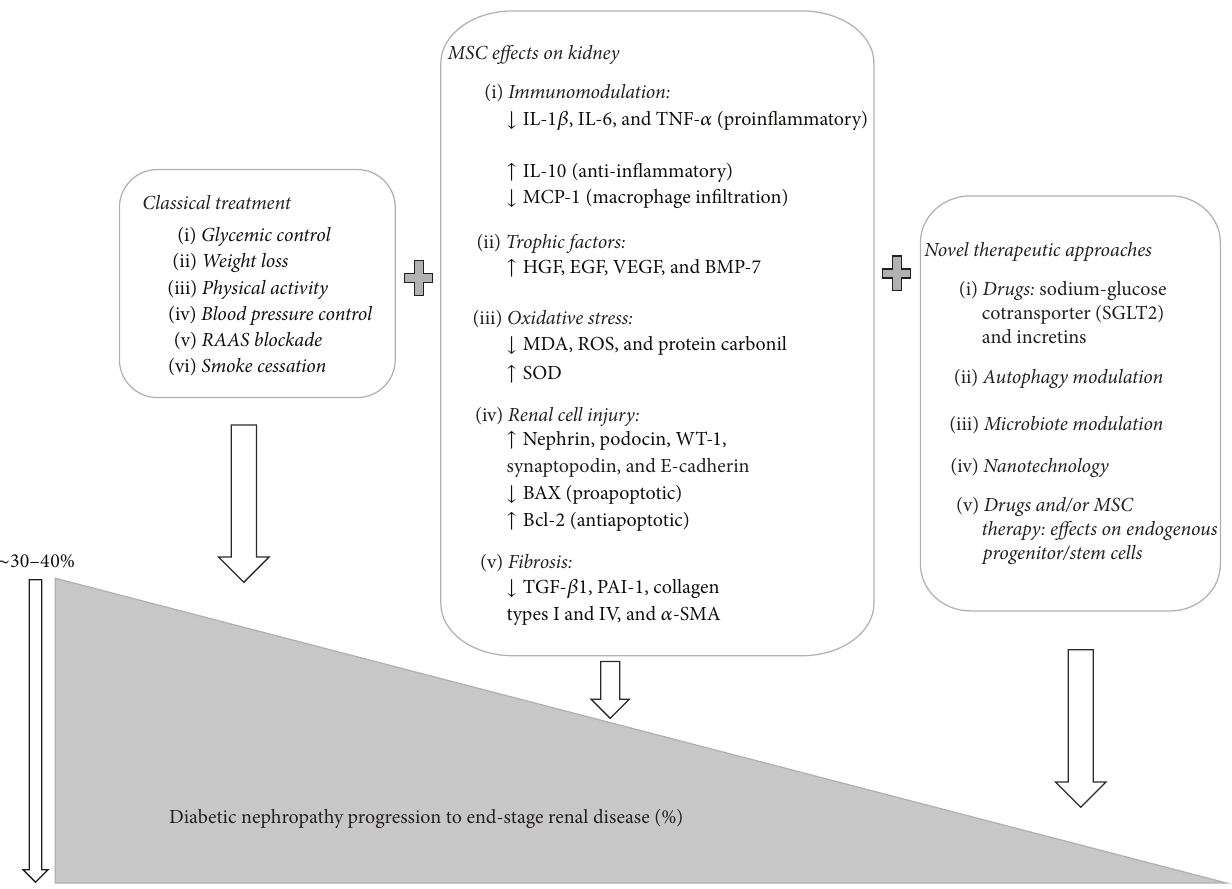
Figure 1: Current treatment to prevent DN, MSC-based therapeutic approaches, and perspectives to halt the progression of DN.